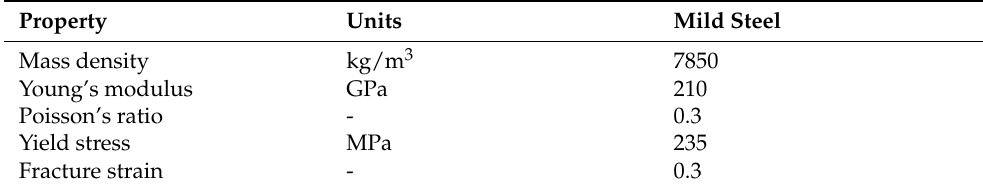
Table 2. Mechanical properties of the material (mild steel).